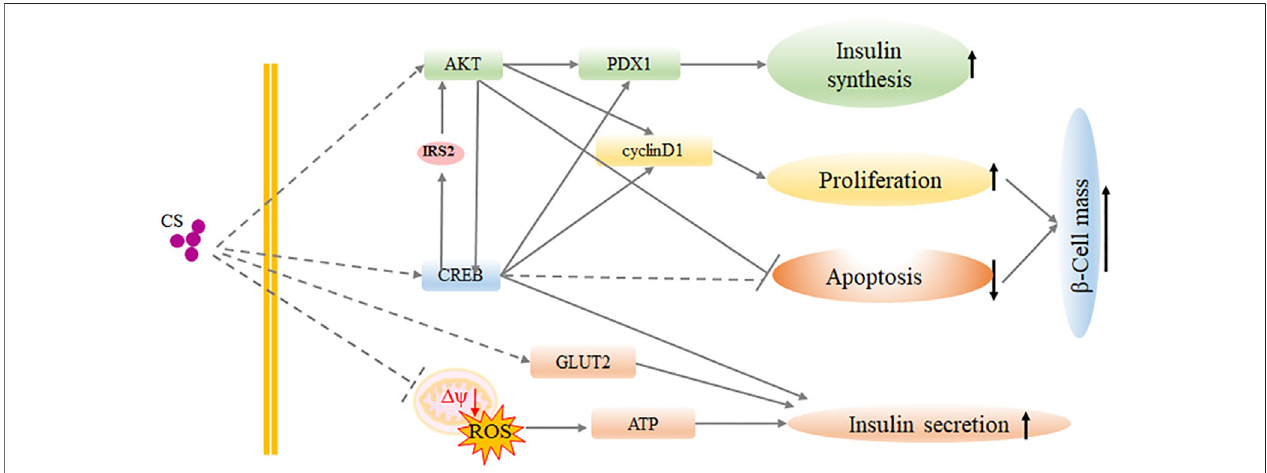
FIGURE 7 | Schematic representation of CS function in β -cell proliferation and